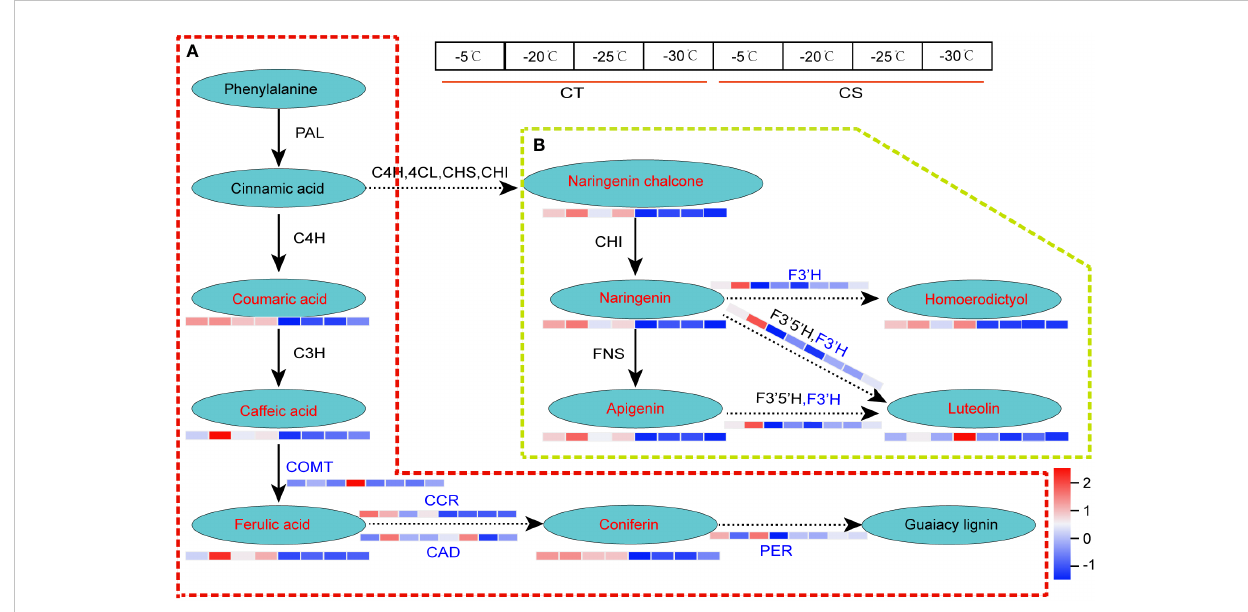
FIGURE 6 DEGs and DEMs involved in phenylpropanoid biosynthesis of peach under cold stress. (A) The DEGs and DEMs involved in the lignin biosynthesis. (B) The DEGs and DEMs involved in fl avonoid metabolism. Letters in red and blue represent the metabolites and genes, respectively. The left and right four parts of the rectangles near the genes/metabolites represented the expression levels of DEGs/DEMs in CT and CS, respectively.